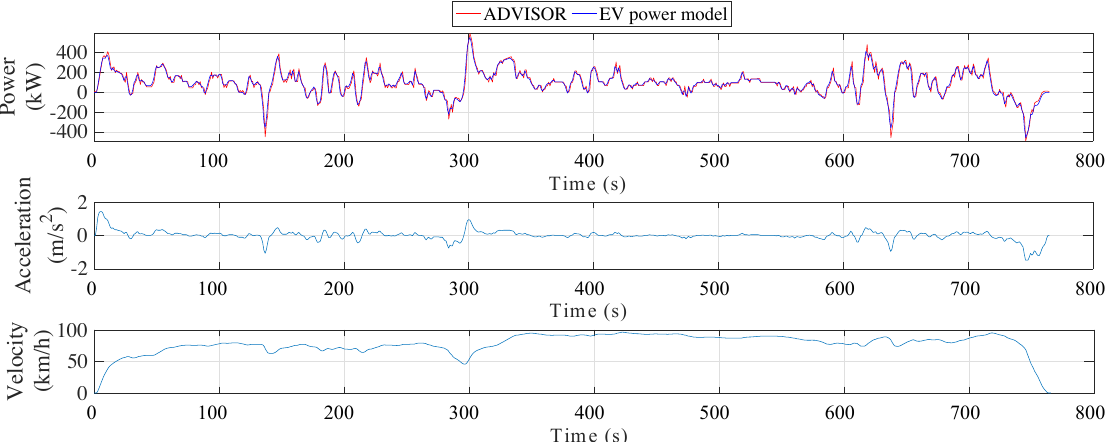
Figure 6. Powertrain model validation results compared with ADVISOR.